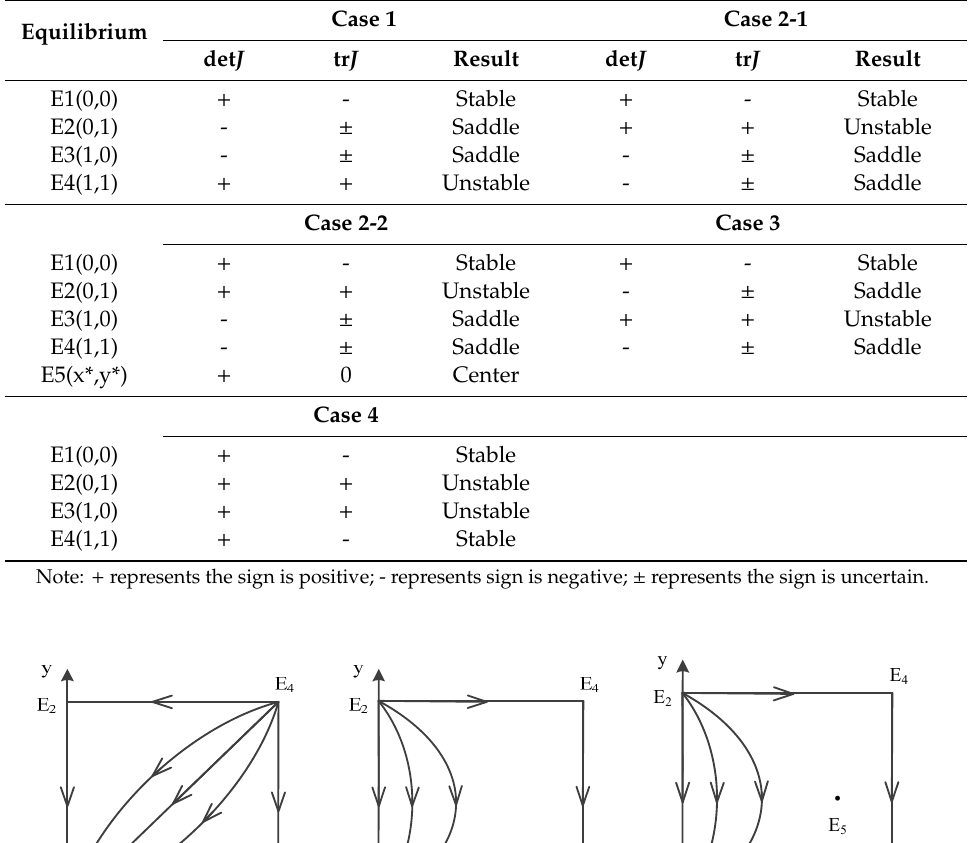
Figure 4. Diagram on dynamic evolution of equilibrium points in E 1 ( 0,0 ) , ( a ) Case 1 ( b ) Case 2-1 ( c ) Case 2-2 ( d ) Case 3 ( e ) Case 4.